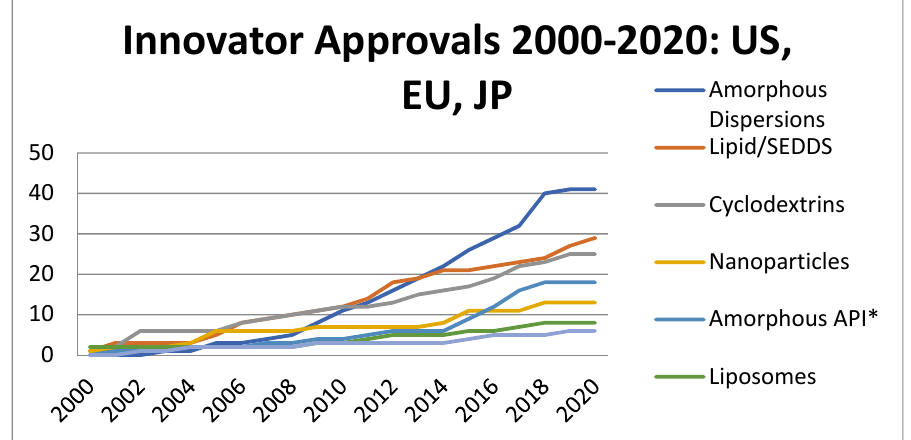
Figure 2. Enabling solubilization technologies used on approved marketed products from 2000 to 2020. * Drug substance formulated as amorphous form instead of ASD (source PharmaCircle™).